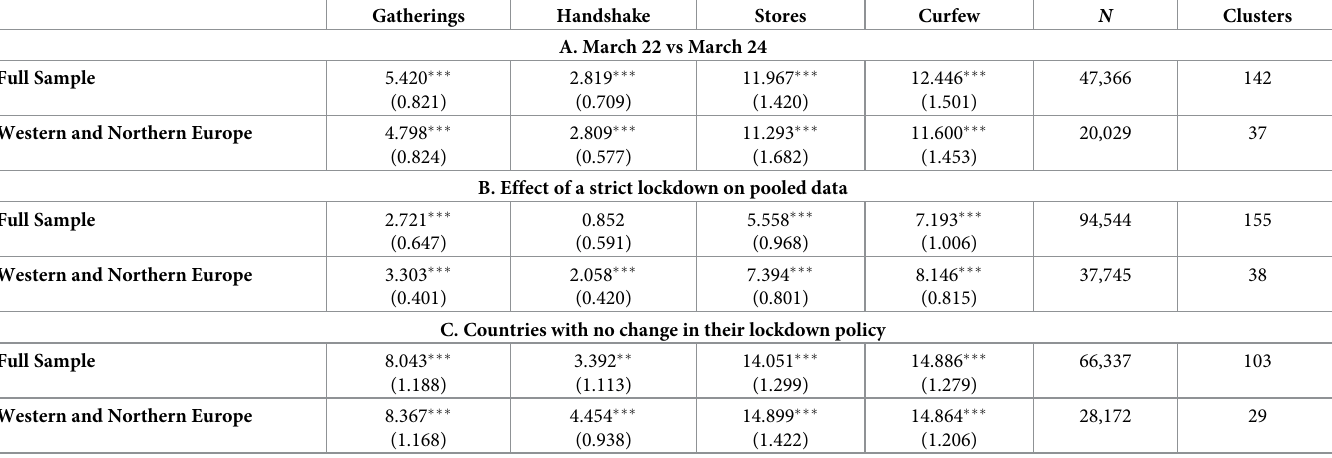
Table 2. Robustness